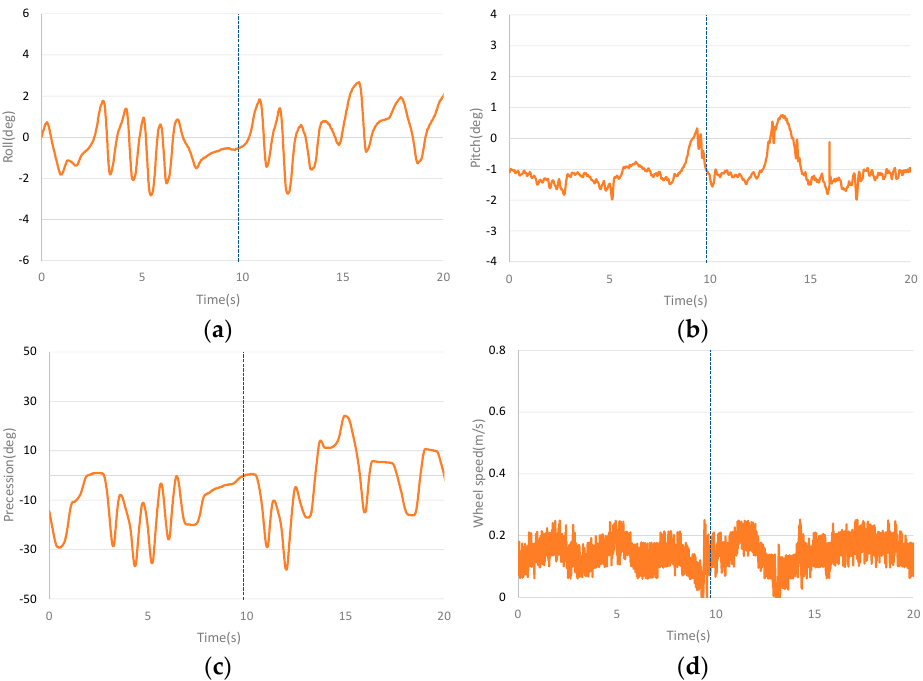
Figure 8. Dynamic balance curves after placing a mass block laterally. ( a ) The roll angle curve of lateral placement of material block experiment. ( b ) The pitch angle curve of lateral placement of material block experiment. ( c ) The precession angle curve of lateral placement of material block experiment. ( d ) The speed curve of lateral placement of material block experiment.